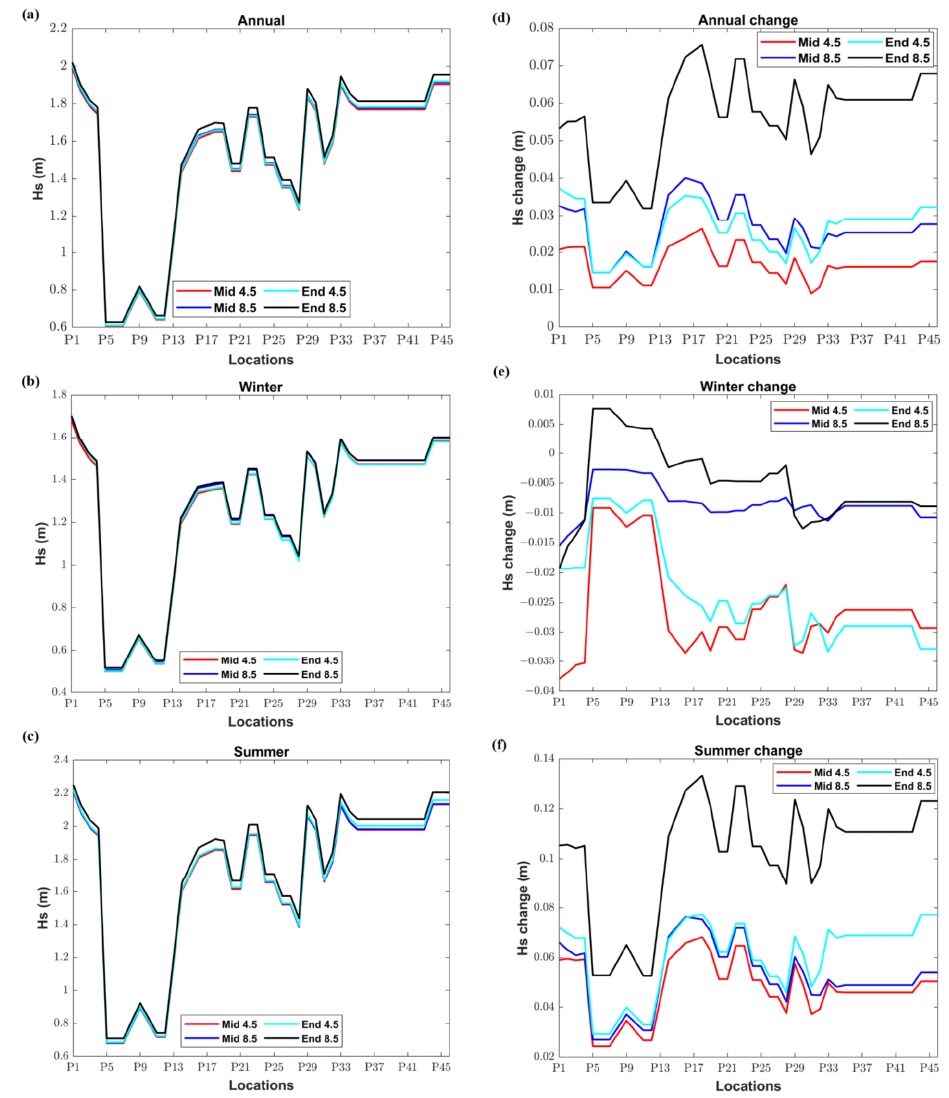
Figure 8. Line plots of the extreme Hs presented as averages for ( a ) annual ( b ) winter, and ( c ) summer. Average change in extreme Hs relative to the past for all future time slices and RCP scenarios for ( d ) annual ( e ) winter, and ( f ) summer.